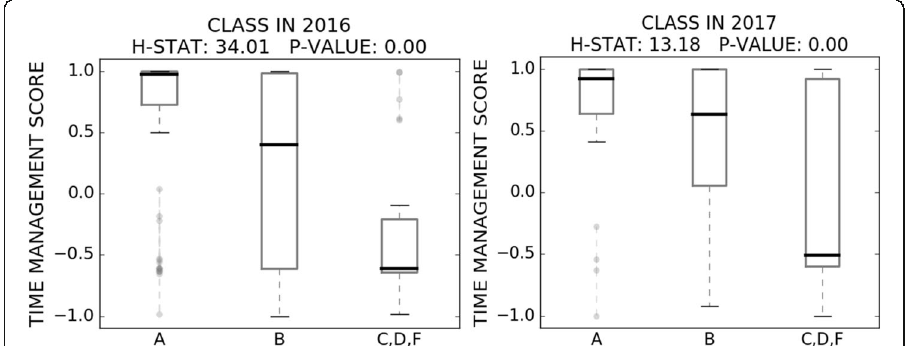
Fig. 8 Distribution of Time Management Score in different grade groups of class in 2016 (left) and in 2017 (right). Lines in bars indicate the median score in each group. H-statistic comes from a Kruskal-Wallis test. Figure based on data and analyses in Park et al.